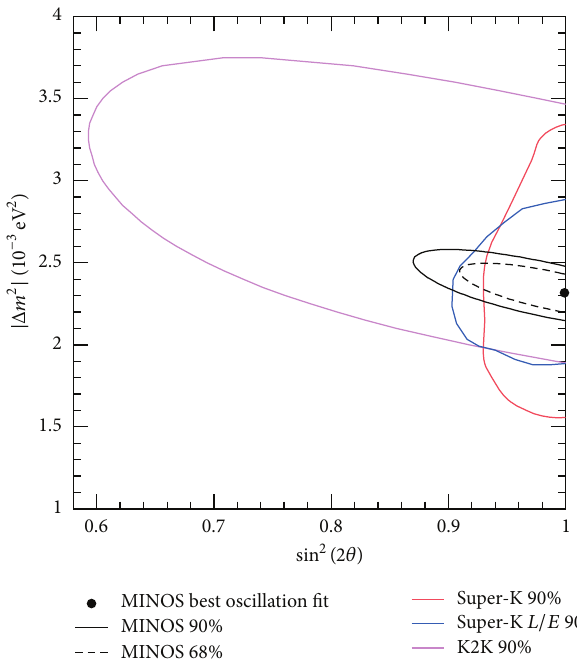
Figure 13: The 90% confidence regions for |Δ𝑚 2 | and sin 2 (2𝜃) . Results shown are published contours from K2K [5], MINOS [40] and Super-Kamiokande [41, 42]. For the latest but still preliminary results see Figure